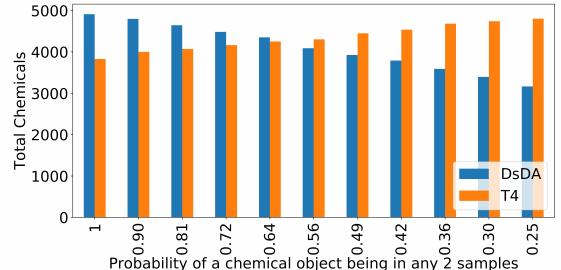
Figure 8. DsDA and Top 4 DDA performance in terms of the number of chemicals fragmented over multiple simulated datasets with varying dropout. In each scenario a percentage of chemicals are dropped from the sample (0%, 5%, 10%, 15%, 20%, 25%, 30%, 35%, 40%, 45%, 50%), meaning that on average samples will become less similar. In these samples, a given chemical object will appear in any two samples with a probability of 1, 0.90, 0.81, 0.72, 0.64, 0.56, 0.49, 0.42, 0.36, 0.30 and 0.25,